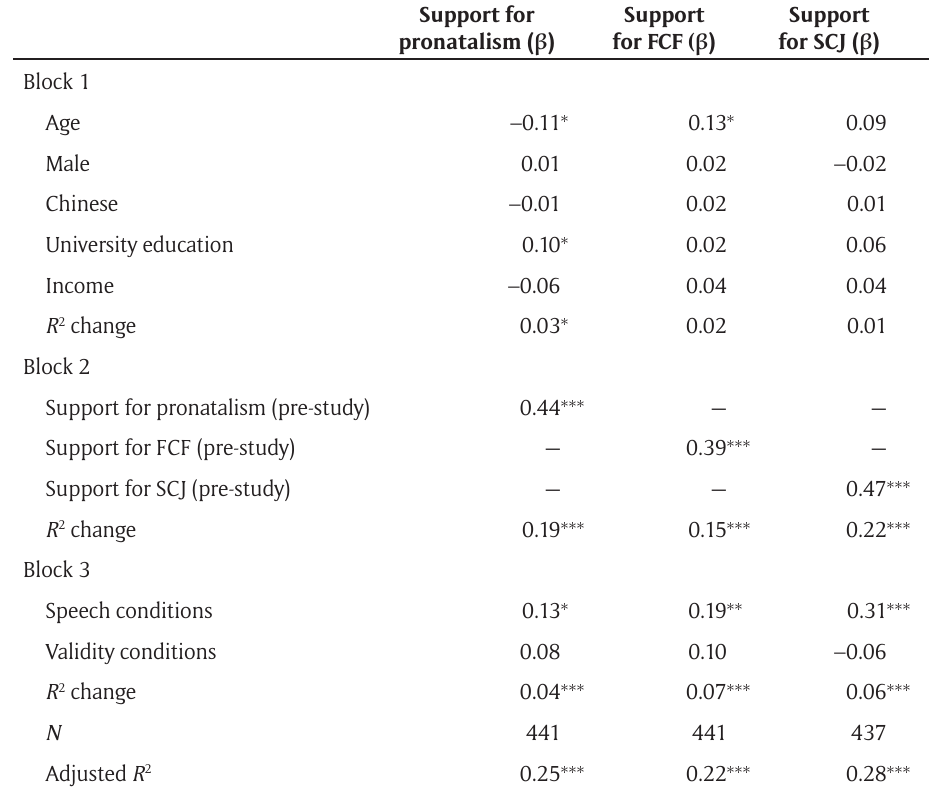
Table 4: Effects of speech and validity conditions on specific policy